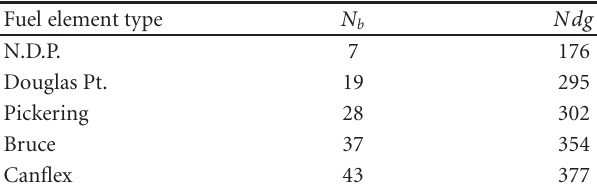
Table 8: Dispersion grade of the CANDU fuel element